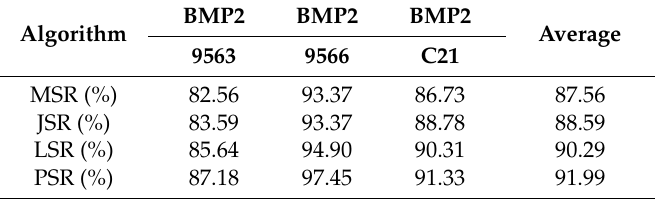
Table 7. The recognition results of each configuration for T72 under the 1024 feature